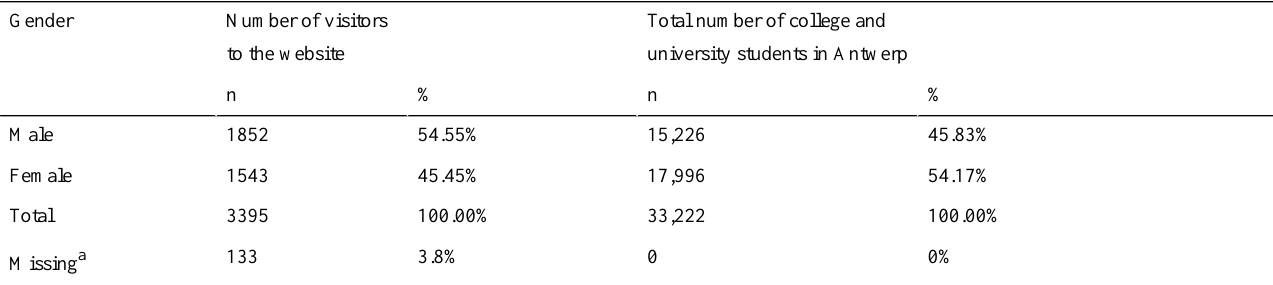
Table 1. Gender division for total number of college and university students in Antwerp and the students who visited the website www.eentjeteveel.be.